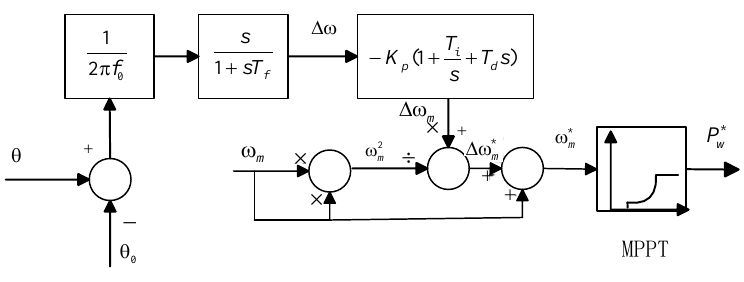
Figure 7. Improved supplementary damping control of DFIG.